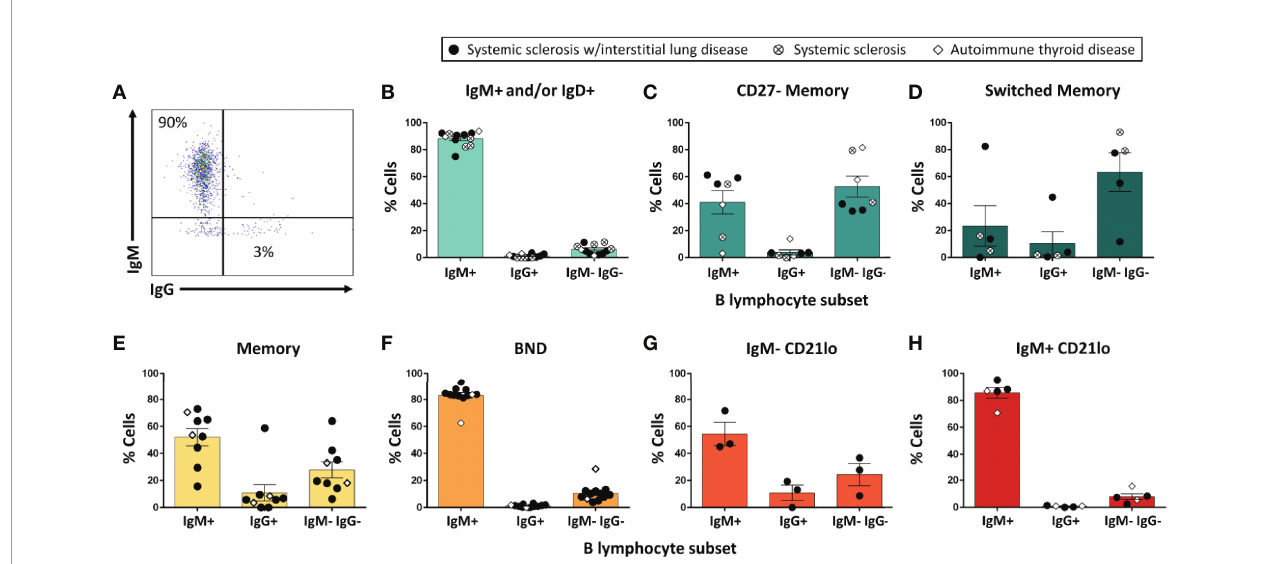
FIGURE 4 | The majority of IgM + and/or IgD+ B cells do not undergo class-switch to IgG following in vitro stimulation. PBMCs were isolated from systemic sclerosis/interstitial lung disease (black circle, n=6 donors; n=35 wells), systemic sclerosis (open circle/X, n=2; n=8 wells), or ATD patients (open diamond, n=1; n=11 wells). Flow cytometry-puri fi ed B cell subsets (identi fi ed as in Figure 1 ) were plated in 384-well plates at ∼ 300 cells/well and stimulated as in Methods for 1 wk. Flowcytometry was used to measure the frequency of IgM + , IgG + , and IgM - IgG - cells among CD19 + live singlet lymphocytes (A) . Flow phenotyping inclusion criteria for this analysis was > 95 lymphocyte events and > 35 CD19 + events. Results for (B) IgM + and/or IgD + , (C) CD27 - memory, (D) CD27 + switched memory, (E) memory, (F) BND, (G) IgM - CD21lo, and (H) IgM + CD21lo B cell subsets are